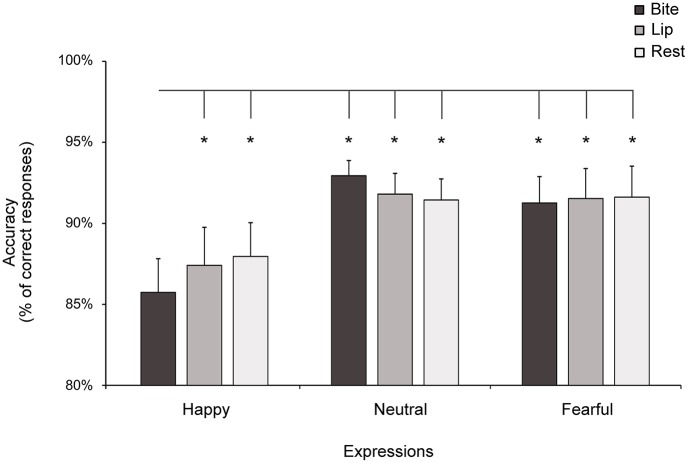
Mean accuracy in Experiment 1.When biting a pen, participants’ ability to recognize happy expressions was decreased relative to all the other conditions. Asterisks indicate significant comparisons. Error bars indicate s.e.m.